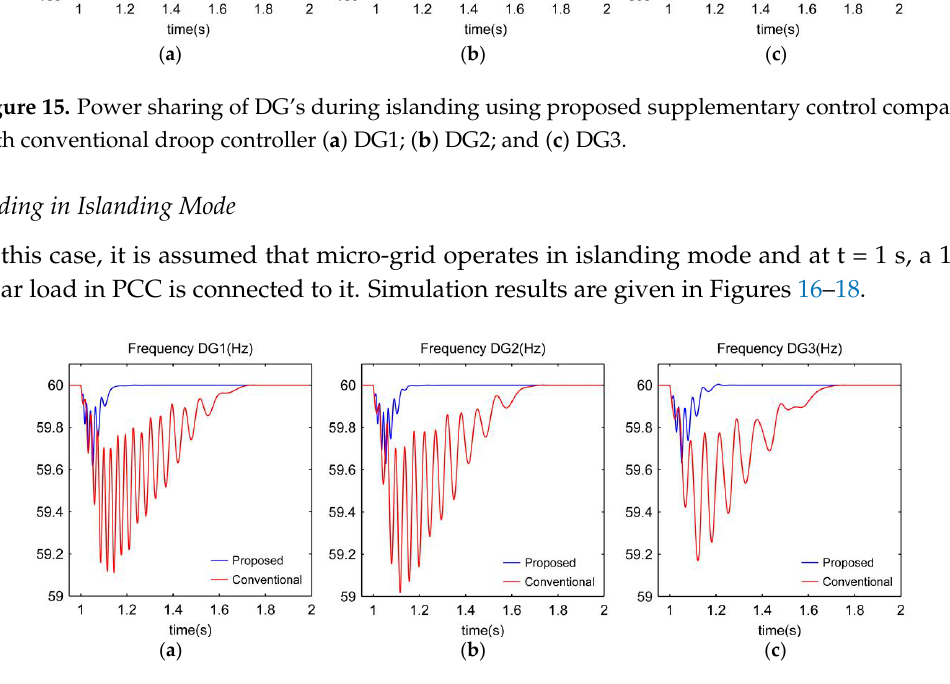
Figure 16. Frequency response of DG’s in load impact condition using proposed supplementary control compare with conventional droop controller ( a ) DG1; ( b ) DG2; and ( c ) DG3.